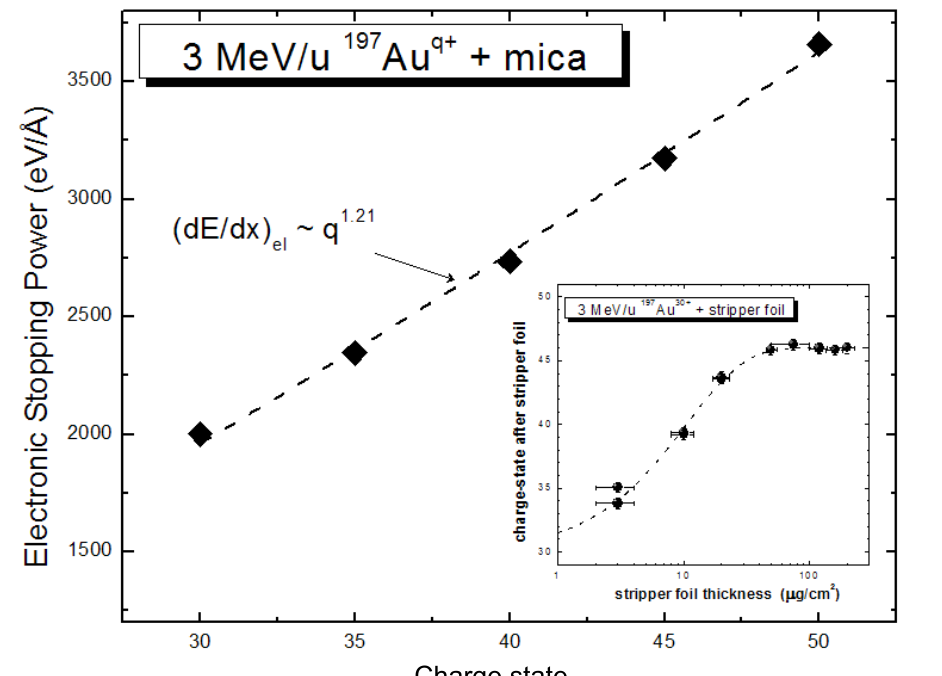
Figure 1. Electronic stopping power for 593 MeV Au beams of different charge states q in mica as calculated by the code CasP6.0 . These Au charge states are obtained from 593 MeV Au 30 + ions exiting amorphous carbon foils of different thicknesses (see inset with data from Grande et al. [50]). Well-defined initial charge states reach the targets, as the beam passes through a series of magnetic analysers in the way to the irradiation